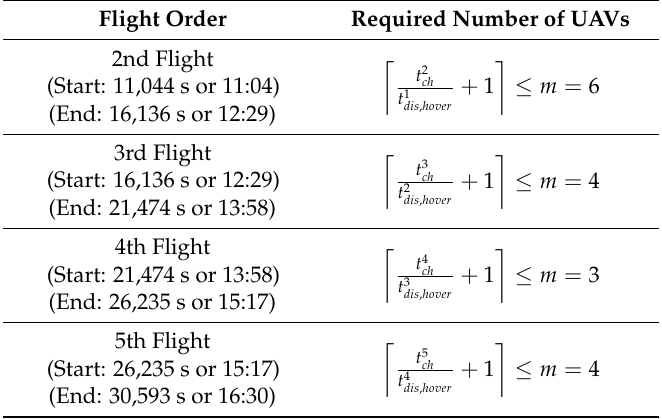
Table 9. Minimum required a number of UAVs for continuous surveillance. Flight Order Required Number of